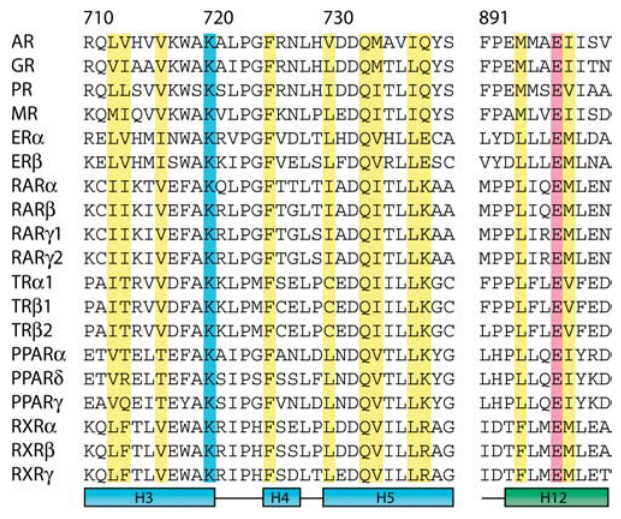
Figure 8. Sequence Alignment of the AF-2 Region of NRs Residues composing the coactivator interface of AR are highlighted in yellow. The absolutely conserved glutamate and lysine composing the charge clamp are highlighted in pink and blue, respectively. Residue numbering is that of